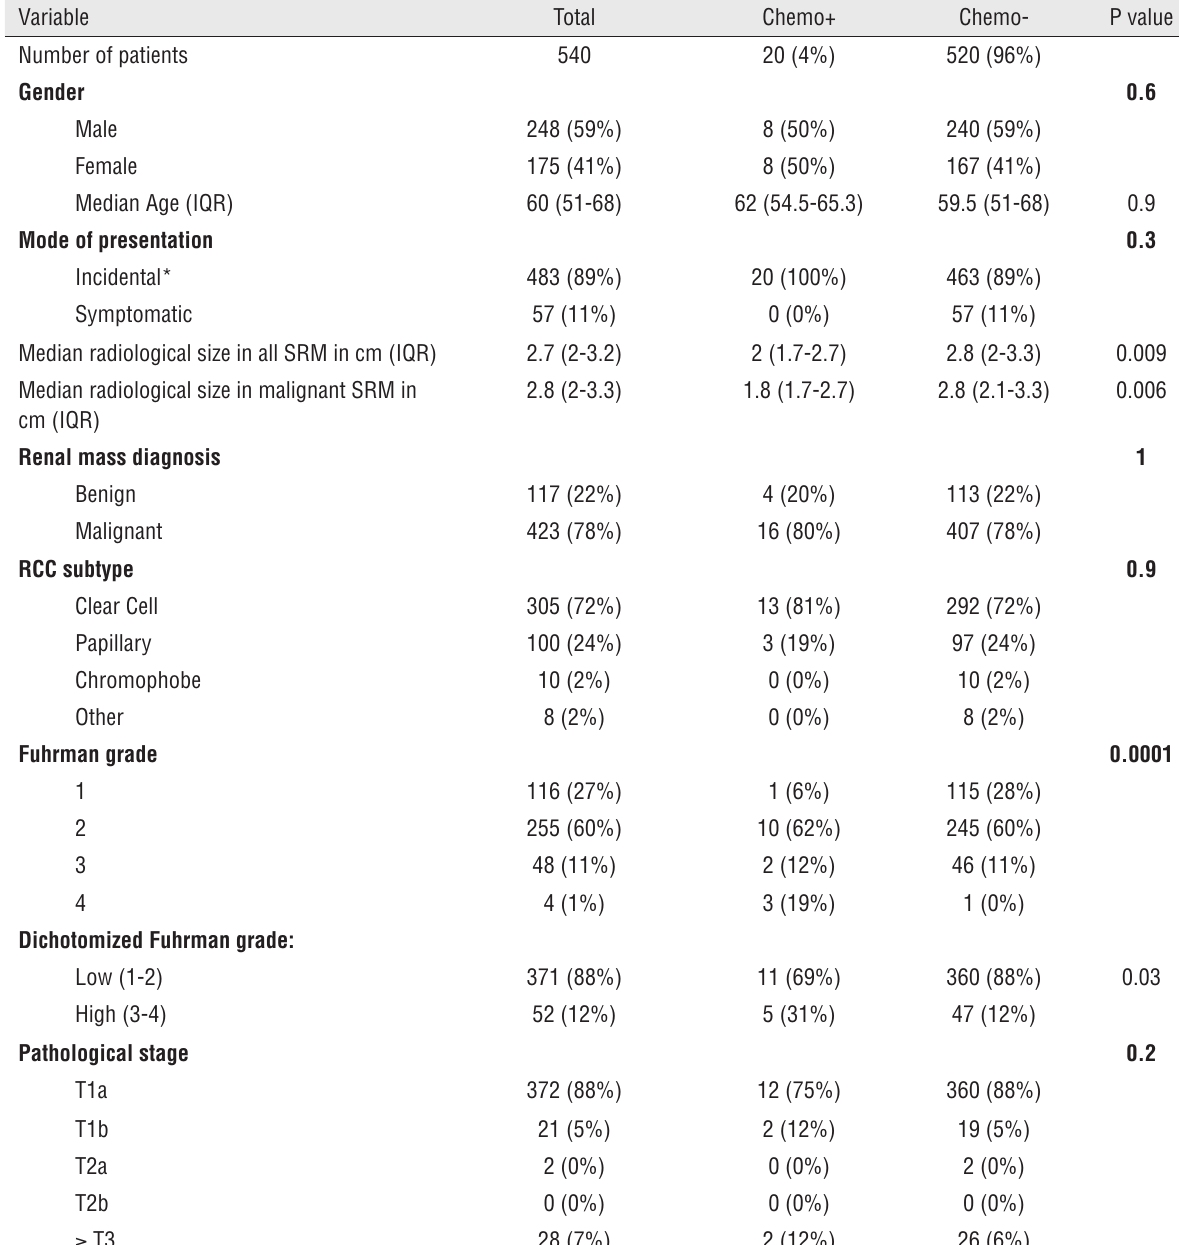
Table 2 - Patient and renal mass characteristics in the SRM